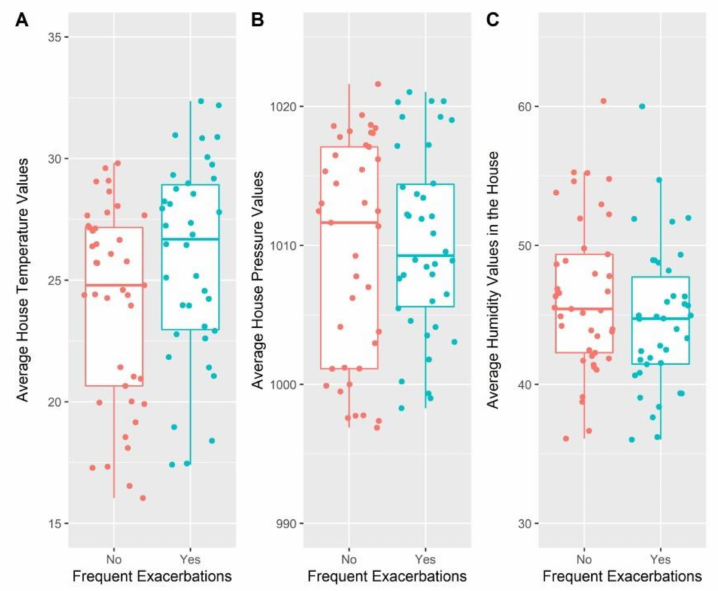
Figure 2. Comparison of the average values of temperature ( A ), atmospheric pressure ( B ) and humidity ( C ) in the participants’ residences according to the exacerbation frequency.